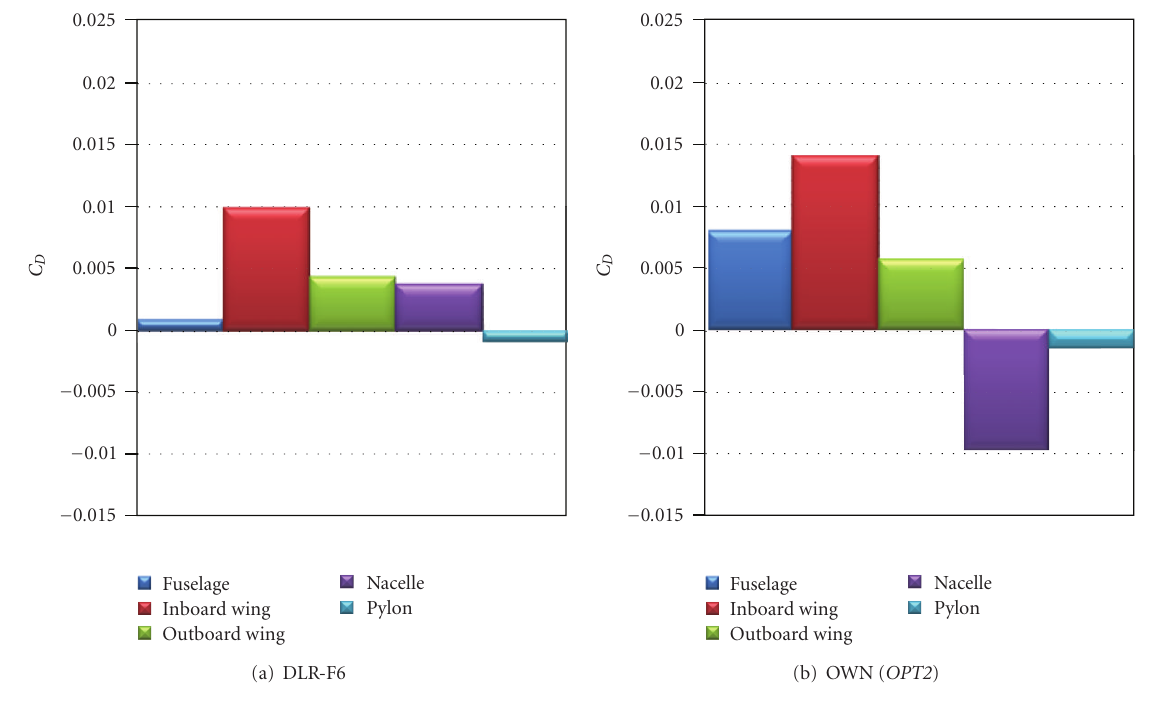
Figure 22: Proportion of pressure drag coe ffi